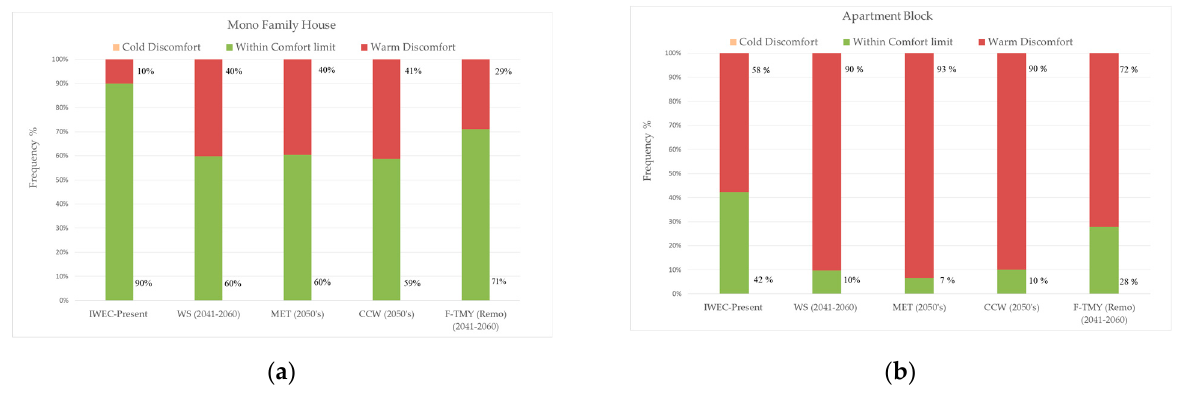
Figure 6. Adaptive comfort analysis for a mono family house ( a ) and apartment block ( b ) for IWEC (Present), Weathershift (WS), Meteonorm (MET), CCWorldWeatehr-Gen (CCW), and F-TMY. All future weather files are for 2050s considering RCP 8.5.